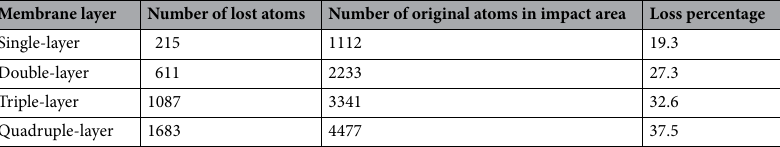
Table 1. The number and proportion of lost atoms of single or multilayer graphene subjected to an impact velocity of 7000